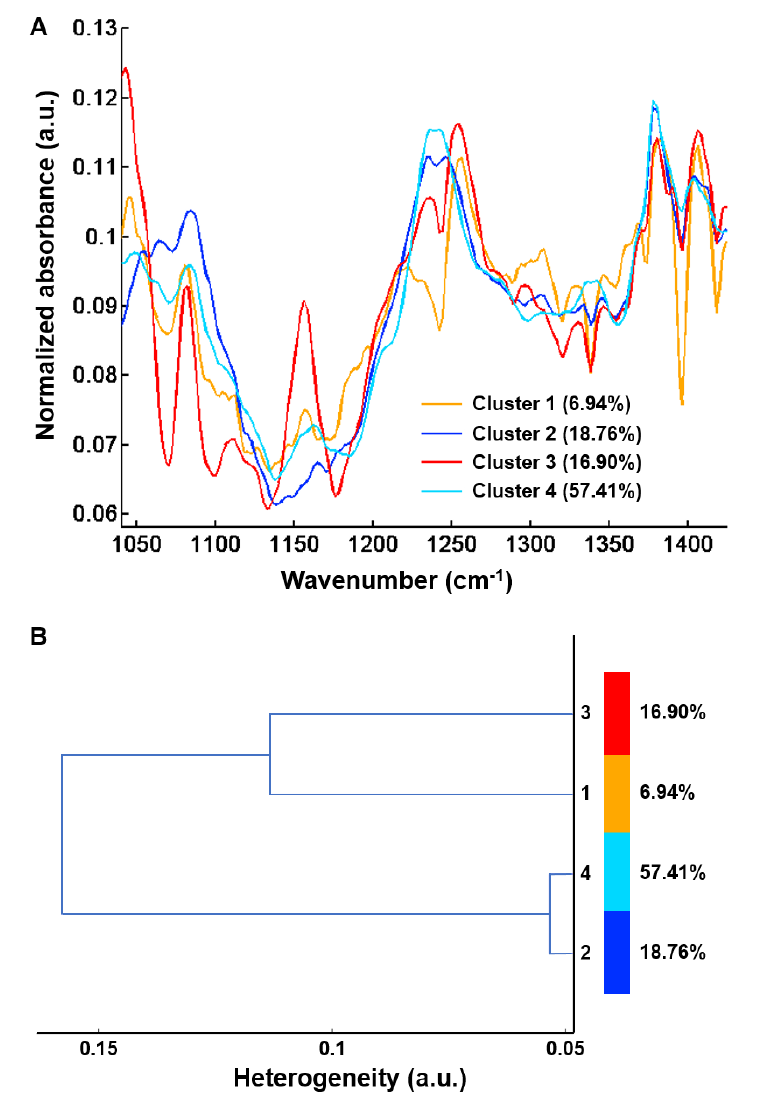
Figure 7. Centroids obtained after common k-means analysis of FTIR spectral images using four classes from 48 hepatic samples without ( n = 25) and with ( n = 23) complications in the 1040–1425 cm − 1 spectral range. ( A ) Centroid spectra and ( B ) Hierarchical cluster analysis of the four centroid spectra. Results are from FTIR images acquired with a projected pixel size of 2.7 μm .